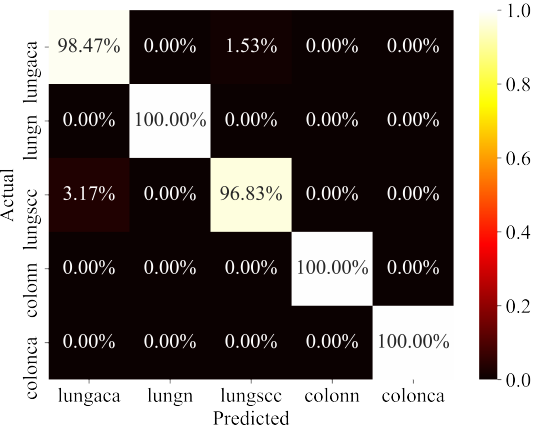
Figure 7. Confusion Matrix.